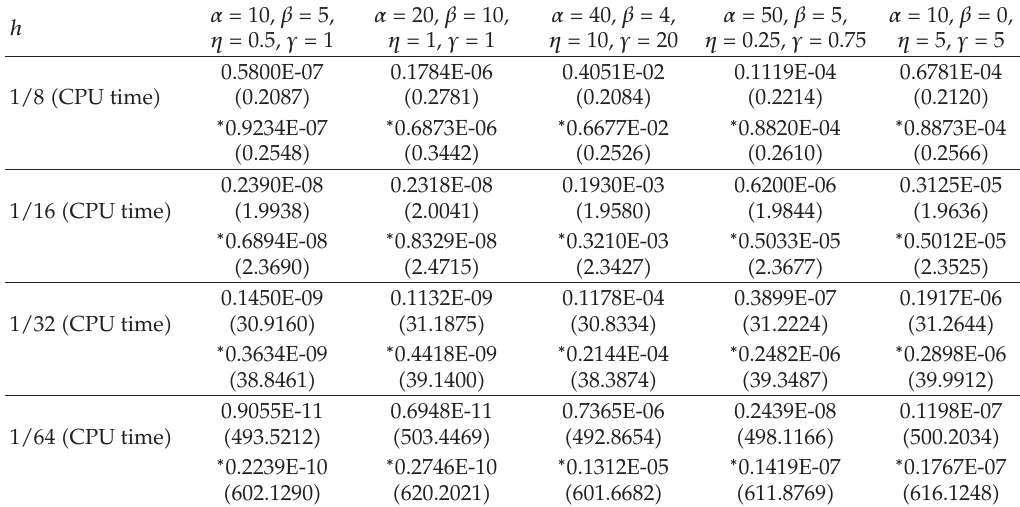
Table 1: Example 6.1: the maximum absolute errors (cid:4) using proposed O (cid:4) k 2 (cid:6) k 2 h 2 (cid:6) h 4 (cid:5) -method (cid:5) (cid:4) with CPU time (cid:5)